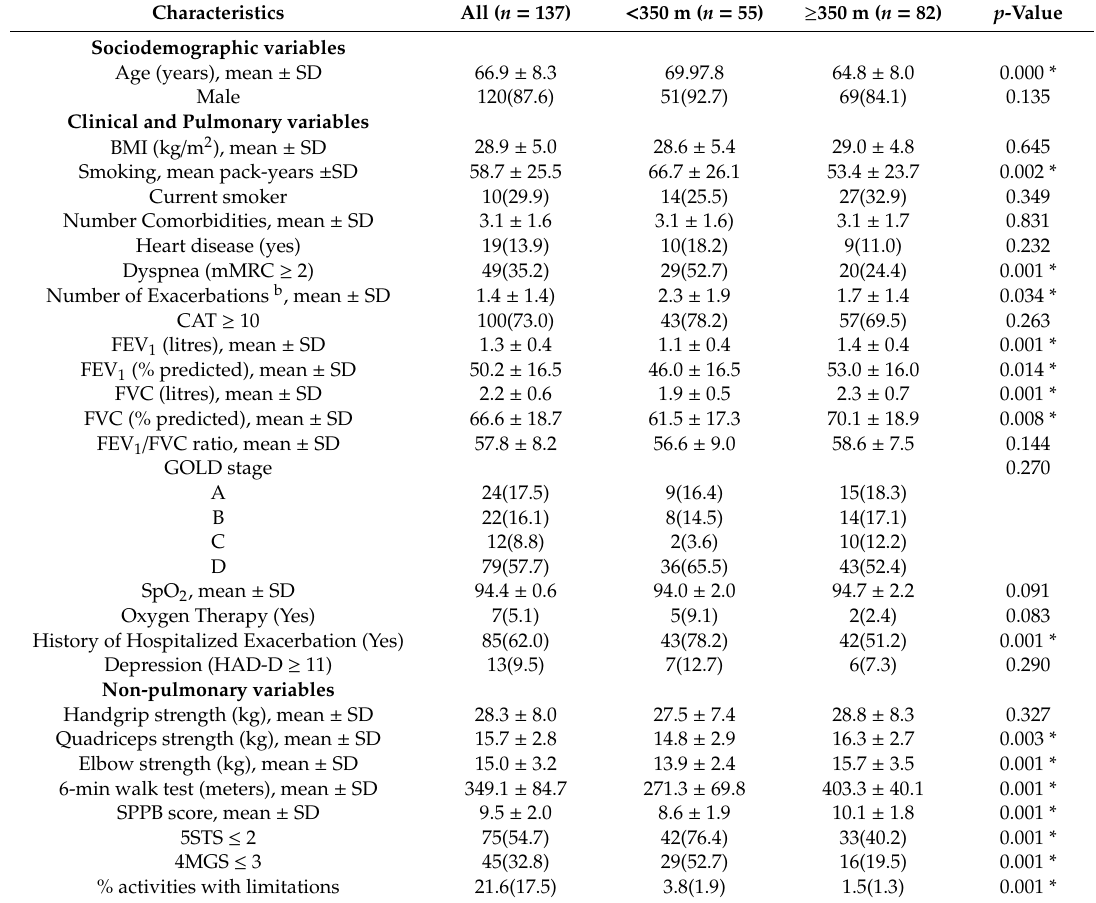
Table 1. Characteristics of the study population ( n = 137), stratified according to poor 6MWT performance a